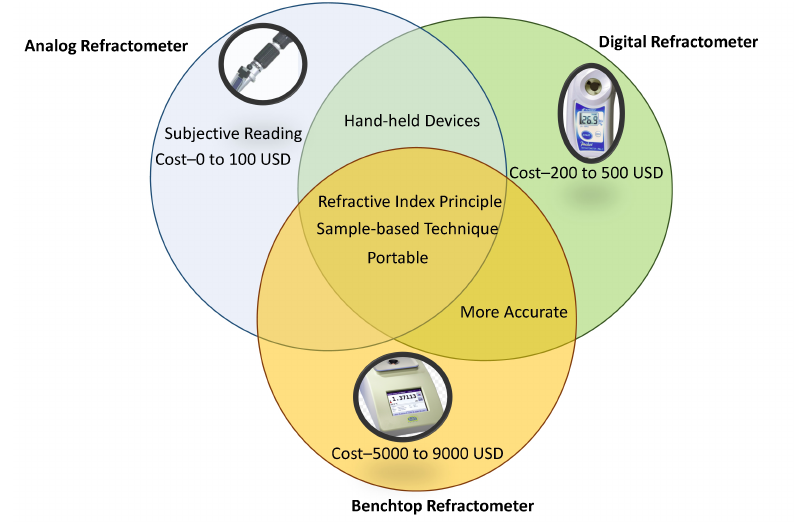
Figure 3. Features of analog, digital, and benchtop